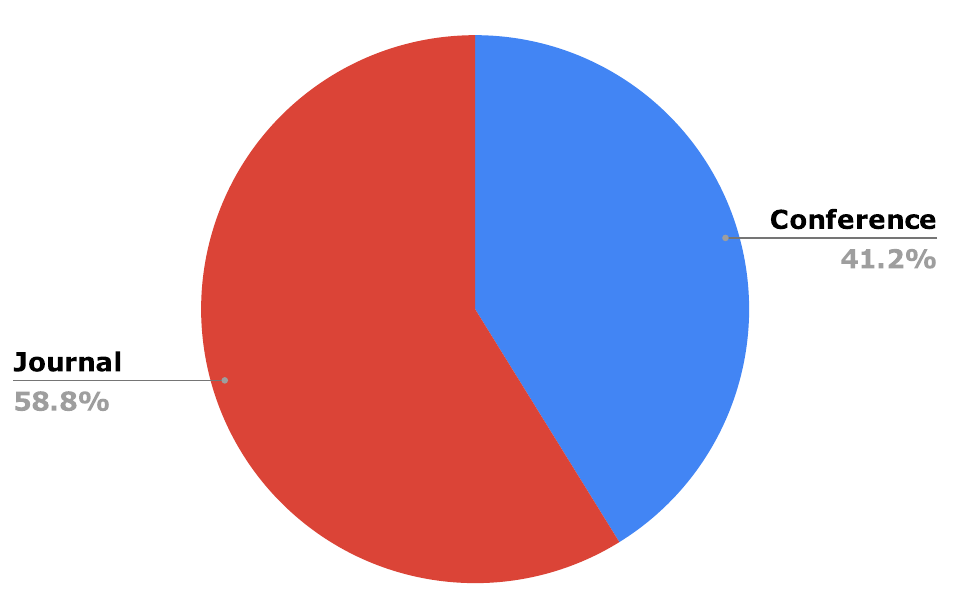
Figure 4. Distribution of articles by publication